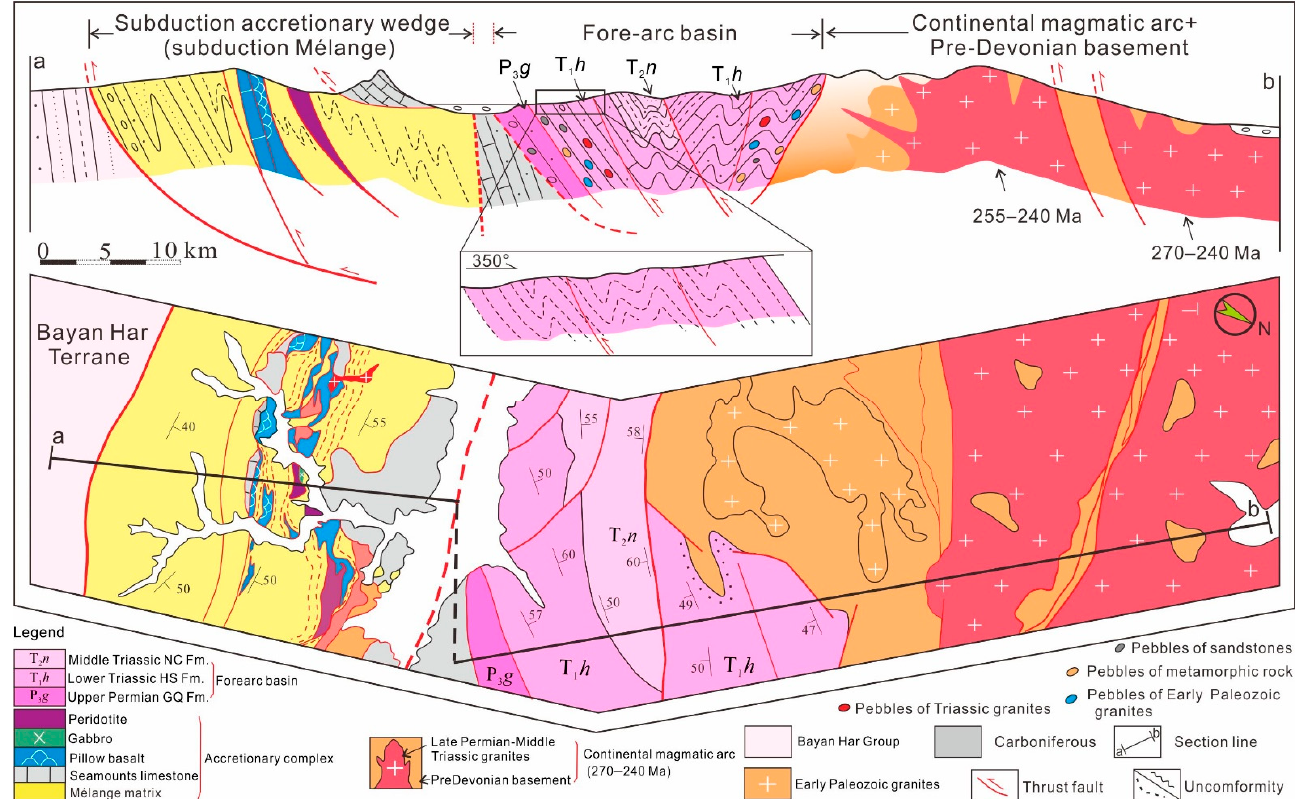
Figure 14. Map of geological transect and accompanying cross-section through the East Kunlun Orogen showing the Buqingshan accretionary wedge, Hongshuichuan forearc basin, and Burhan Budai continental arc from south to north.